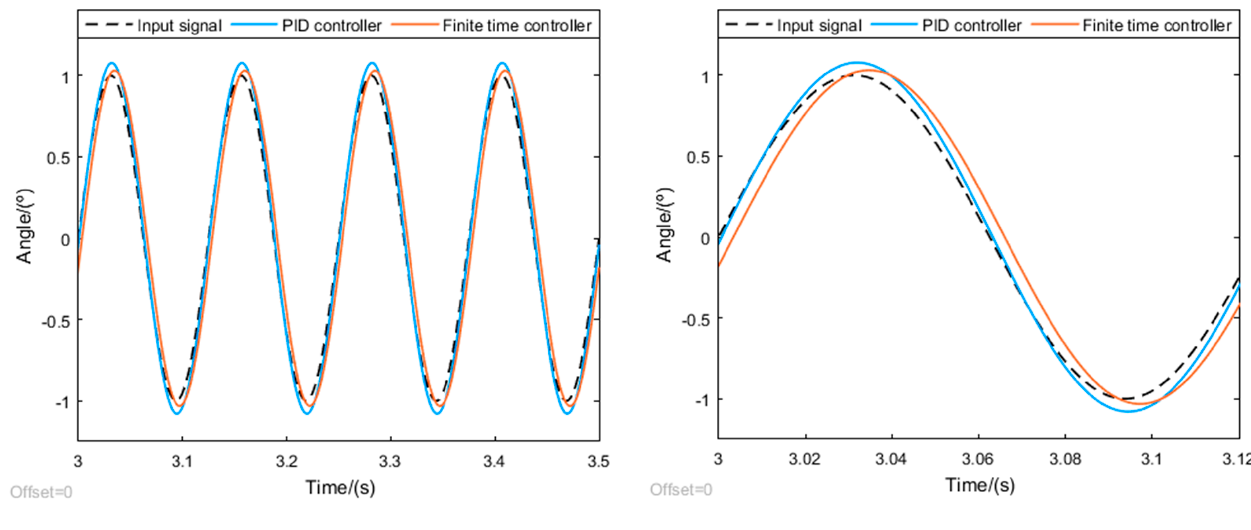
Figure 7. Finite-time composite control response curve of the motor system with 8 Hz and 1° sinusoidal signal.